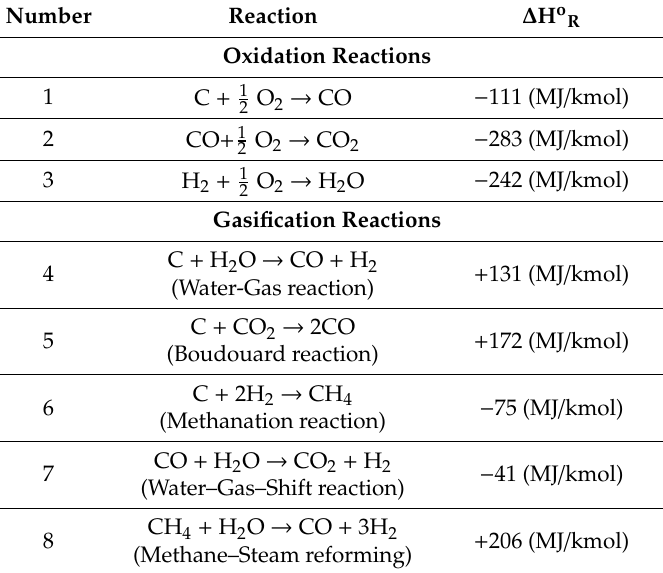
Table 1. Oxidation and gasification reactions in biomass thermal conversion